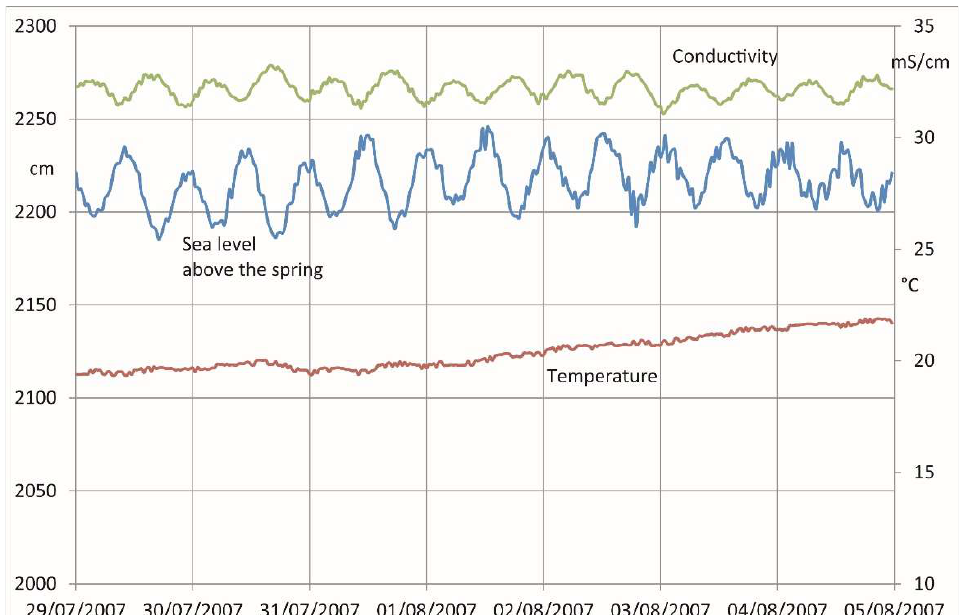
Figure 6. Variation of groundwater conductivity and temperature at Chekka KSMS during low stage, compared to sea level above the spring. The 50 cm range tide effect is at the opposite of the salinity variation, an increase of the sea level being related to a decrease of salinity.